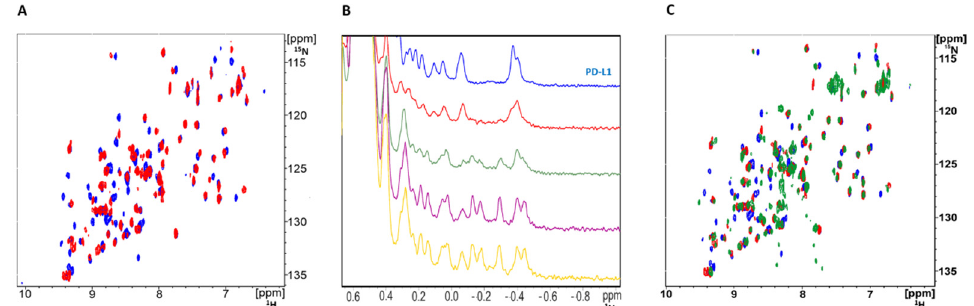
Figure 1. NMR indicates the physical interaction of p104 with PD-L1. ( A ) 1 H- 15 N HMQC spectra of 15 N labeled PD-L1 (blue) and the same protein in the presence of p104 (red). ( B ) 1 H NMR titration of PD-L1 (blue) with peptide p104 in the molar ratios 5:1 (red), 2:1 (green), 1:1 (purple), and 1:2 (yellow). ( A , B ) Significant shifts observed in positions of resonance peaks indicate interaction of p104 and PD-L1. ( C ) 1 H- 15 N HMQC spectra of apo-PD-L1 (blue) and the same protein in the presence of p104 (red) or p101 (green) in the molar ratio 1:1.